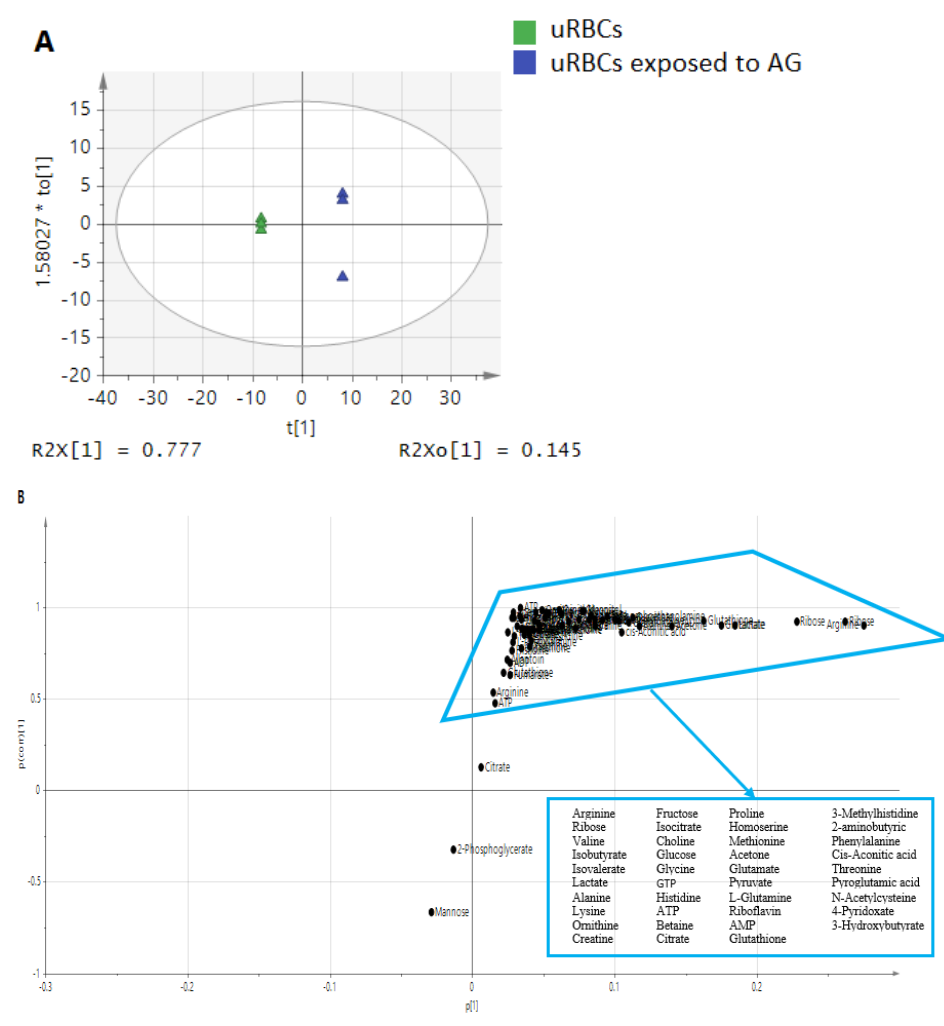
Figure 3. The OPLS-DA score scatter plot ( A ) and S-plot ( B ) of the blood metabolic profiles of unin- fected RBC samples. uRBCs; uninfected red blood cells, AG; andrographolide. uninfected RBC samples. uRBCs; uninfected red blood cells, AG;